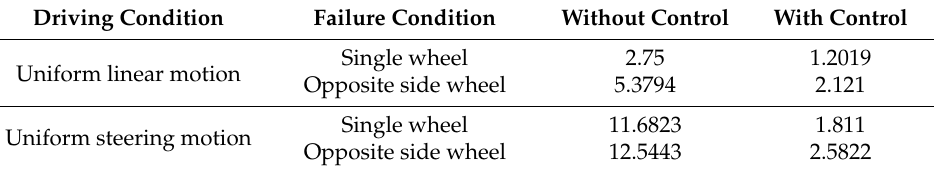
Table 2. Maximum speed deviation with or without control (km/h).